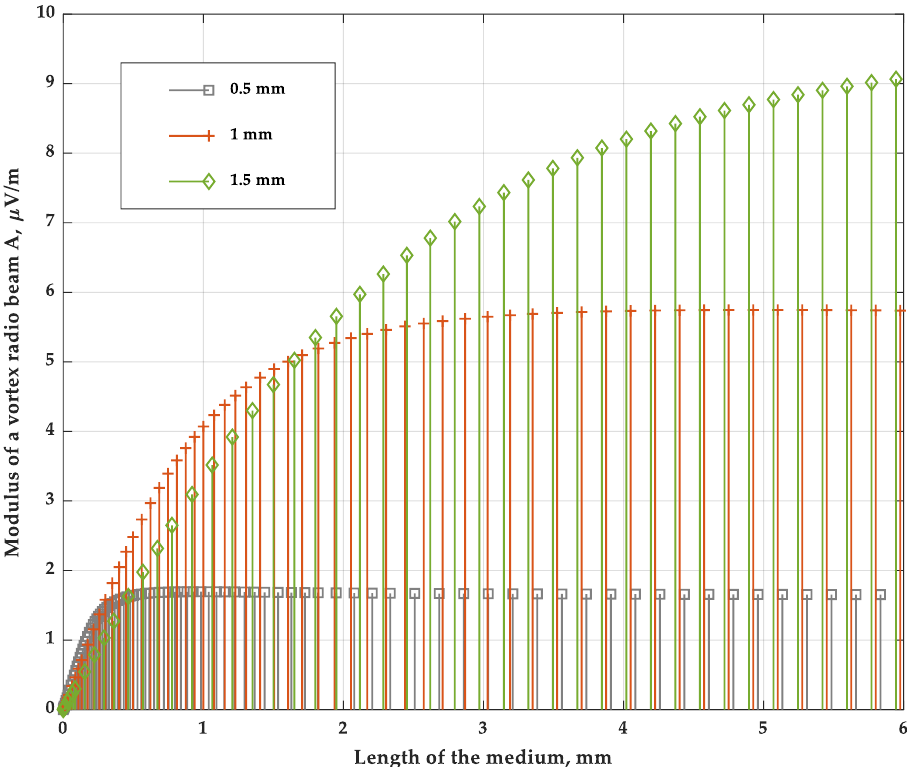
Figure 2. Dependence of the modulus of a vortex radio beam A on the length of a nonlinear medium z for three values of the waist radius of laser beams.